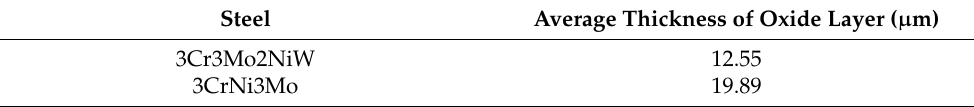
Table 3. Average thickness of oxide layer for two Cr-Ni-Mo hot-work die